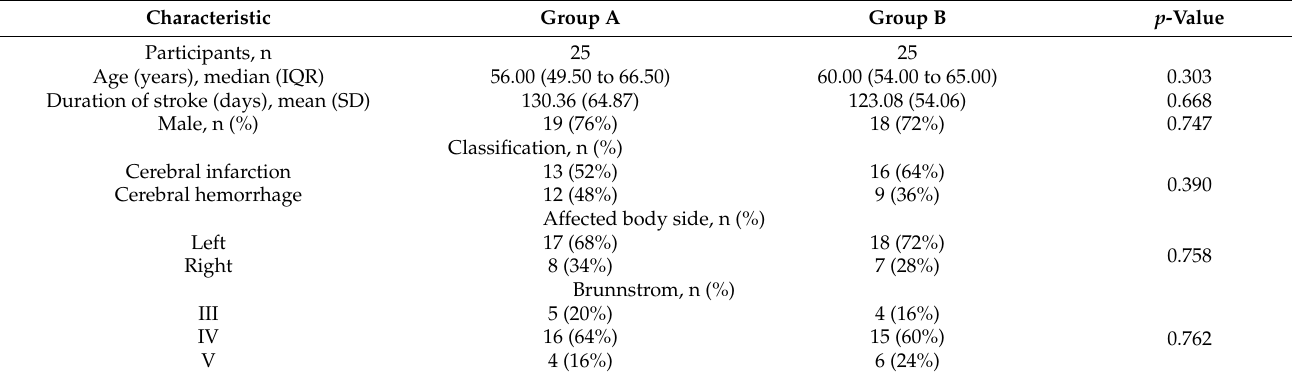
Table 1. Patient characteristics at baseline (Group A: experimental group; Group B: control group).